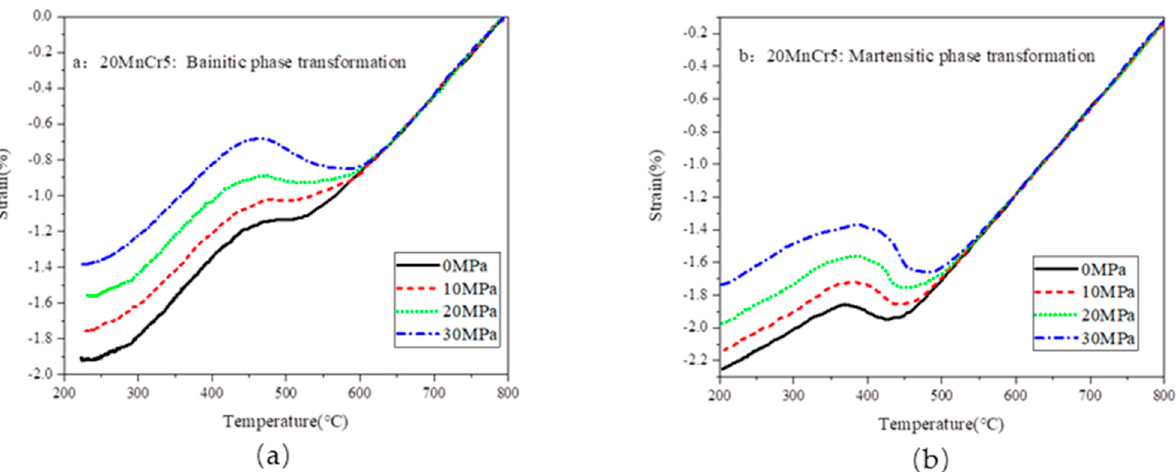
Figure 8. Temperature–strain diagrams of the 20CrMnTiH steel. ( a ) Temperature–strain diagram of the bainitic phase; ( b ) temperature–strain diagram of the martensitic phase.